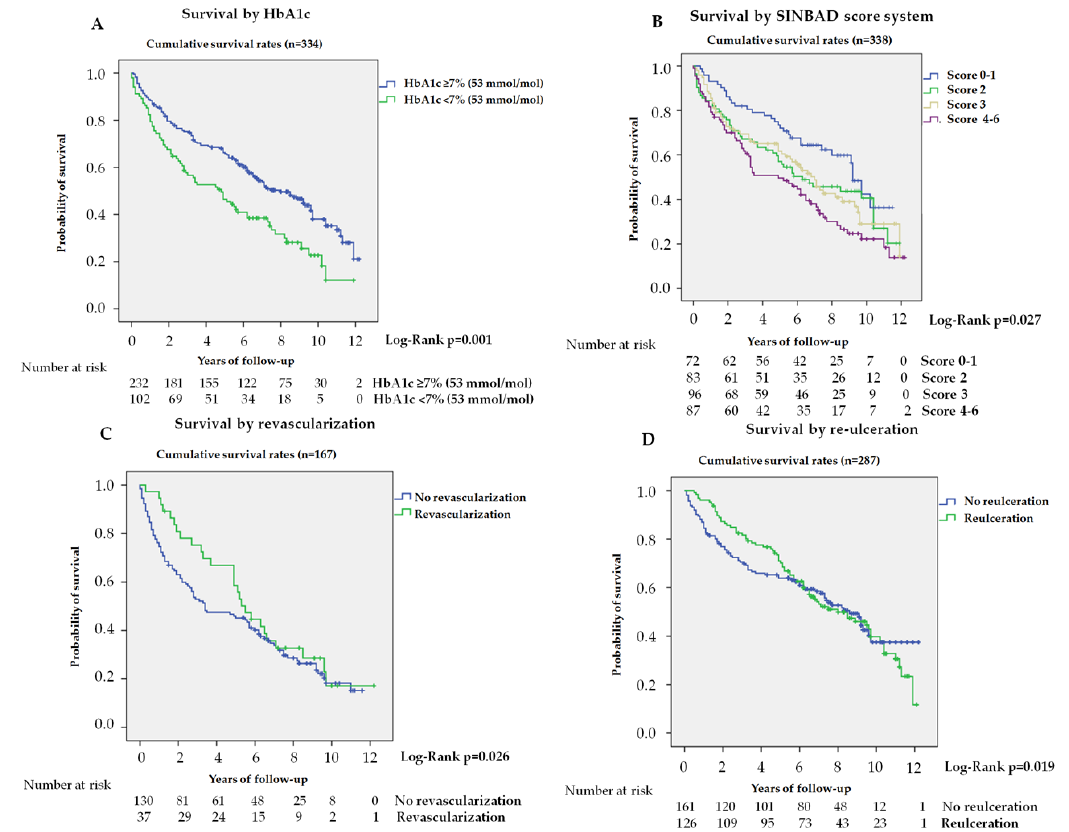
Figure 2. Kaplan — Meier curves for survival. ( A ): Survival by HbA1c in total cohort (n = 334, 4 subjects no data). ( B ): Survival by SINBAD score system (n = 338). ( C ): Survival by revascularization in patients with ischemic lesion (n = 167). ( D ): Survival by reulceration in patients after the resolution of the DFU and without major amputation (n = 287).